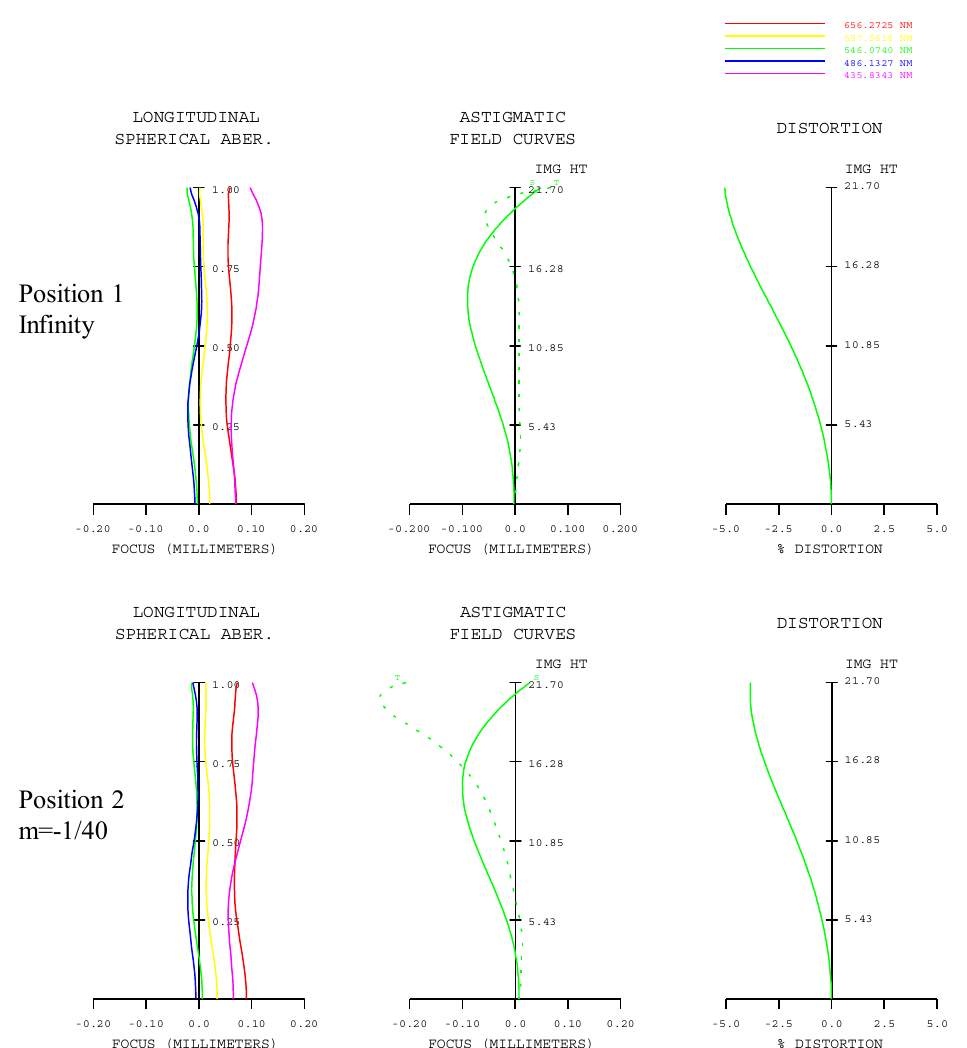
Figure 9. Spherical aberration degree of the final design at the infinity and principal shooting distance.